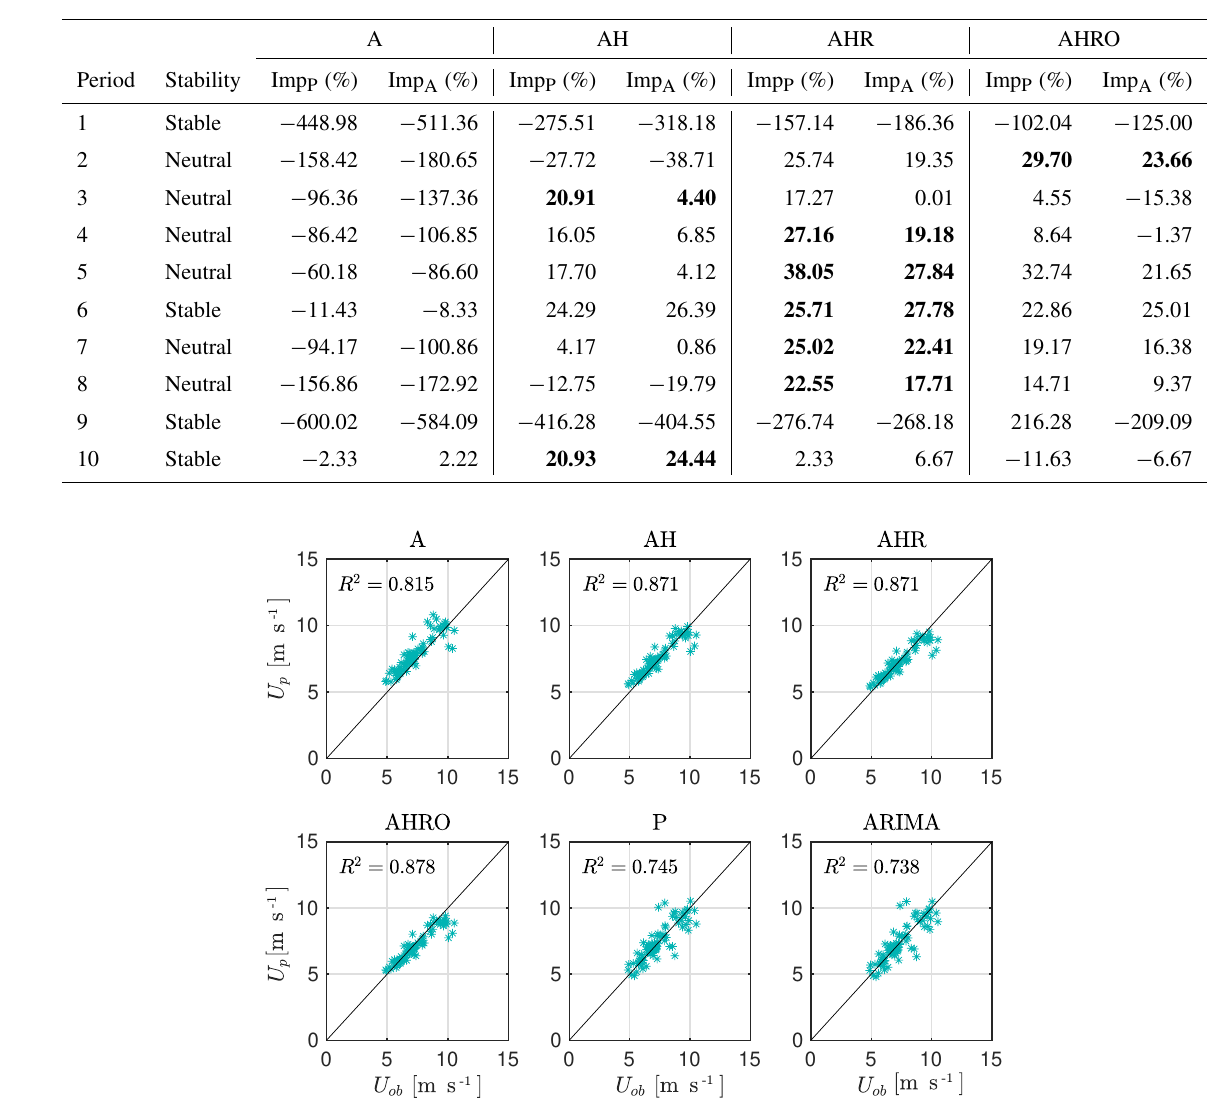
Table 4. Improvement of all advection models over the benchmarks persistence (Imp P ) and ARIMA (Imp A ). Values corresponding to best performance are indicated in bold.